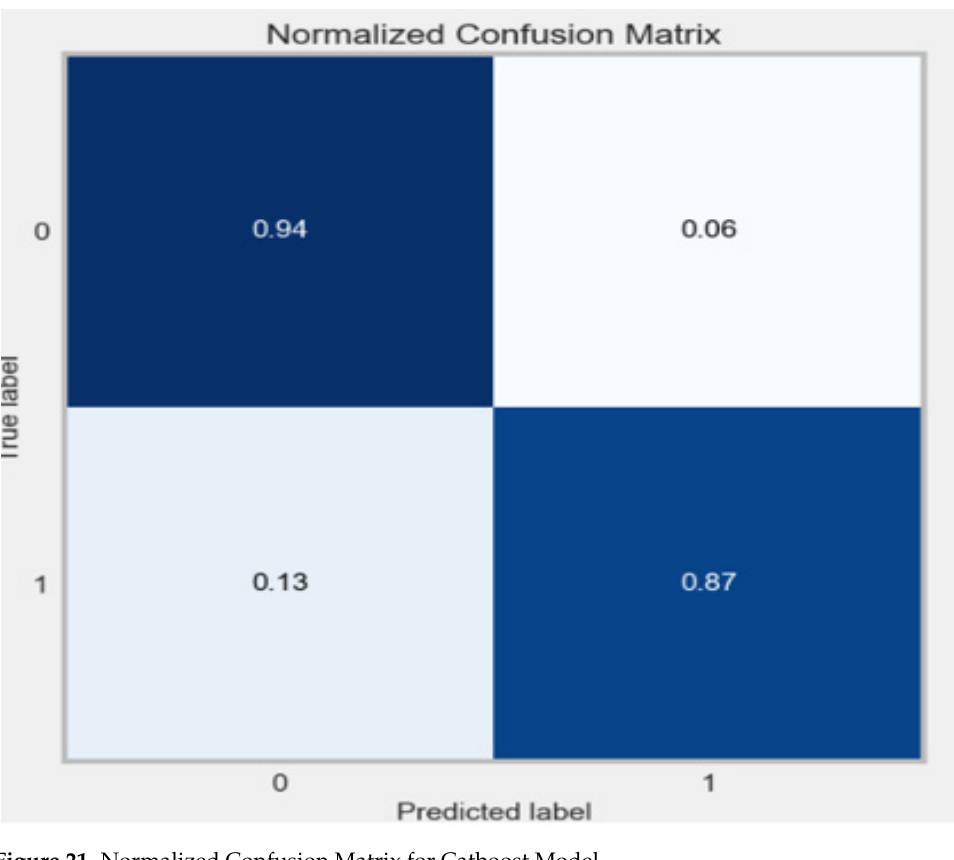
Figure 21. Normalized Confusion Matrix for Catboost Model.